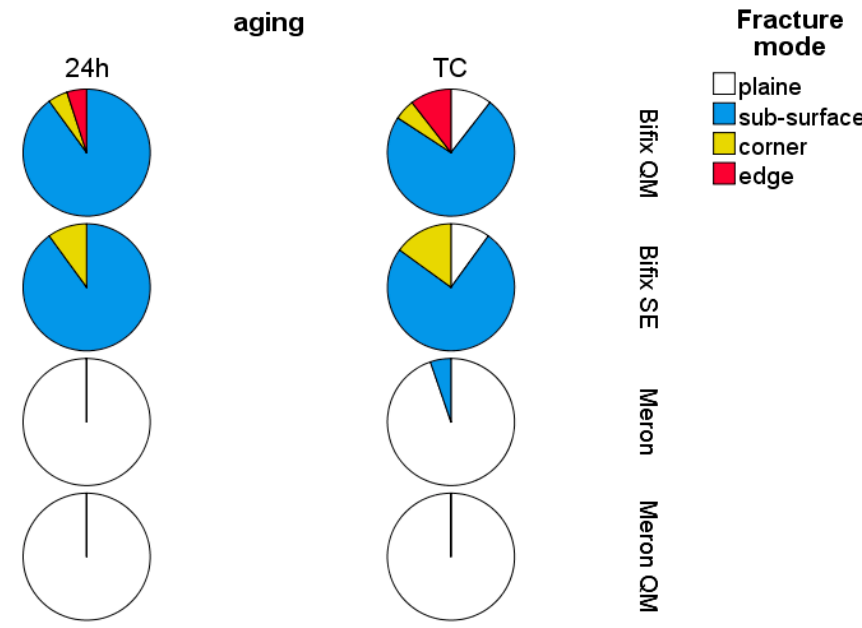
Figure 3. Fracture modes as a function of luting material and aging